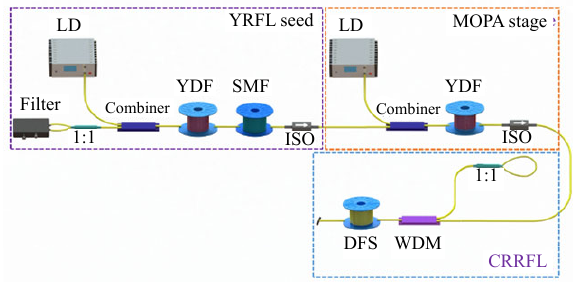
Fig. 1 Experimental setup of CRRFL pumped by tunable random lasing.